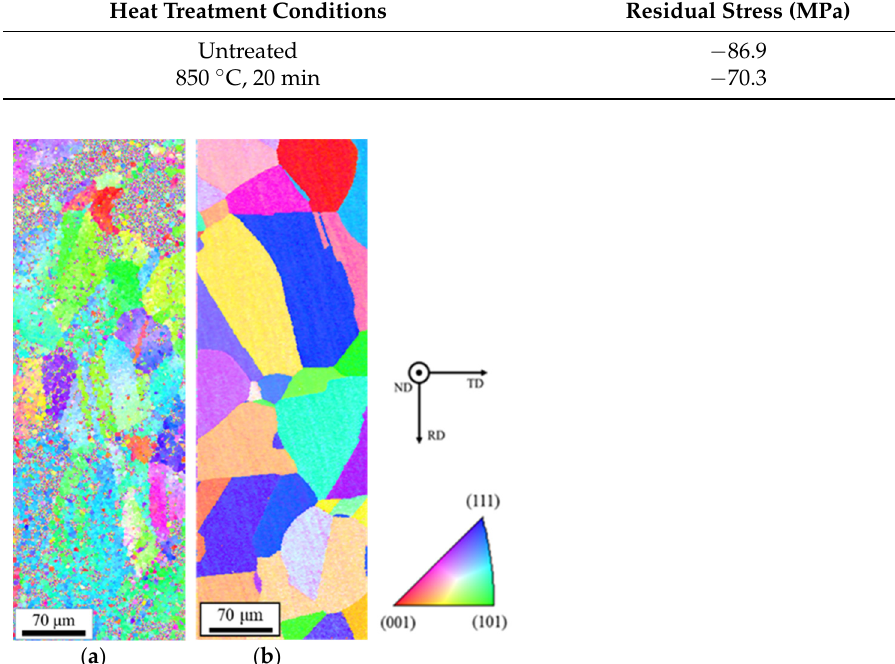
Figure 3. Inverse pole figure ( IPF) maps estimated by electron backscattering diffraction (EBSD) analysis. ( a ) Untreated; ( b ) heat-treated at 850 °C for 20 min.